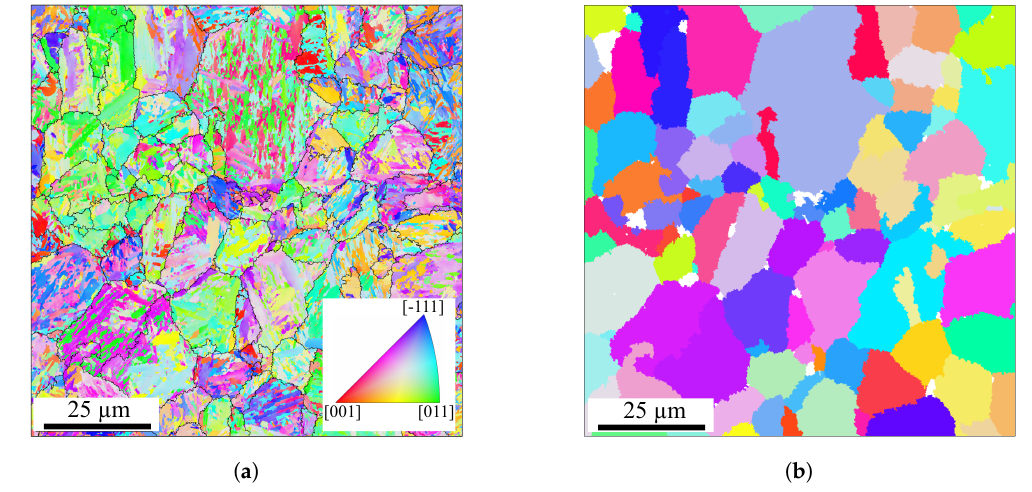
Figure 2. Martensitic microstructure of the SAE 4150. ( a ) EBSD map in inverse pole figure colour code with superimposed prior austenite grain boundaries. ( b ) Corresponding prior austenite grains calculated with ARPGE under assumption of Nishiyama-Wassermann orientation relationship.